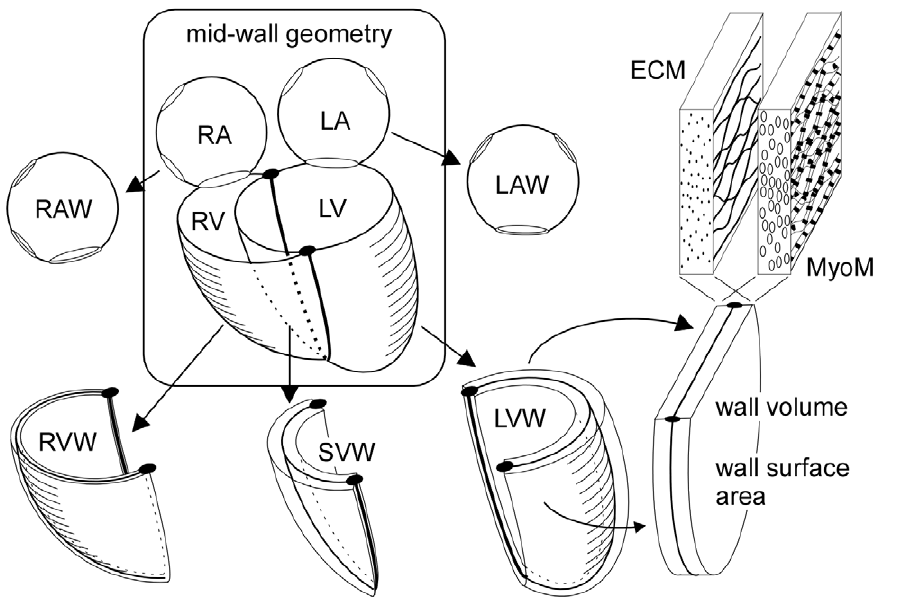
Figure 2. Composition of the heart by 5 walls with MyoM and ECM. Curved mid-wall surface form the core of macroscopic geometry of atria and ventricles. Left and right atrium (LA, RA) are enclosed by single curved walls (LAW, RAW). The ventricular unit is composed of left, septal and right ventricular wall (LVW, SVW and RVW), enclosing left and right ventricle (LV, RV). Geometry of each wall is deducted from unfolding the wall to a flat surface. Each wall has a volume and a mid-wall area. A wall contains a myocyte matrix (MyoM) intertwined with the extracellular matrix (ECM). Both matrices have their own reference mid-wall area, linking their ultrastructure to the macroscopic geometry of the wall.